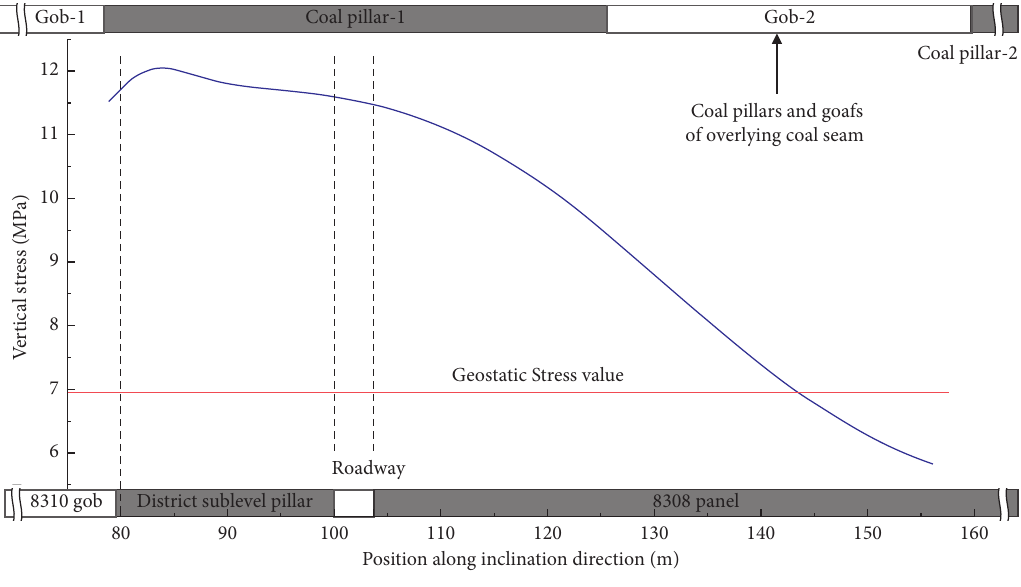
Figure. 8: Vertical stress distribution on both sides of the gob-side roadway at the Section